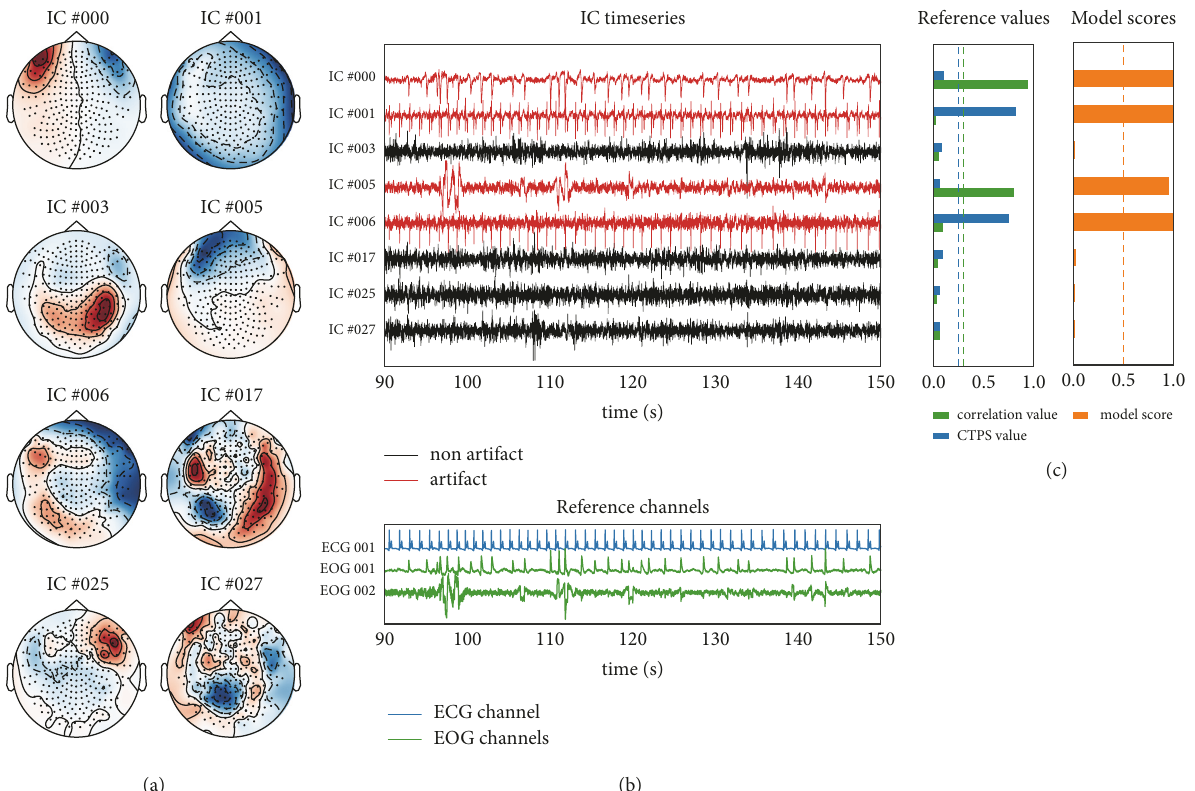
Figure 5: (a) Topoplots showing spatial ICA components extracted from one sample recording in the validation dataset. (b) The corresponding temporal ICA components extracted from the same data. Components identified as artifacts are highlighted in red. ECG (blue) and EOG (green) signals are shown for comparison. (c) The corresponding classification results provided by the reference and the model. Reference values include CTPS for ECG in blue and Pearson’s correlation coefficients for EOG in green. The model probability (scores) is shown in orange. Thresholds used are indicated by dashed